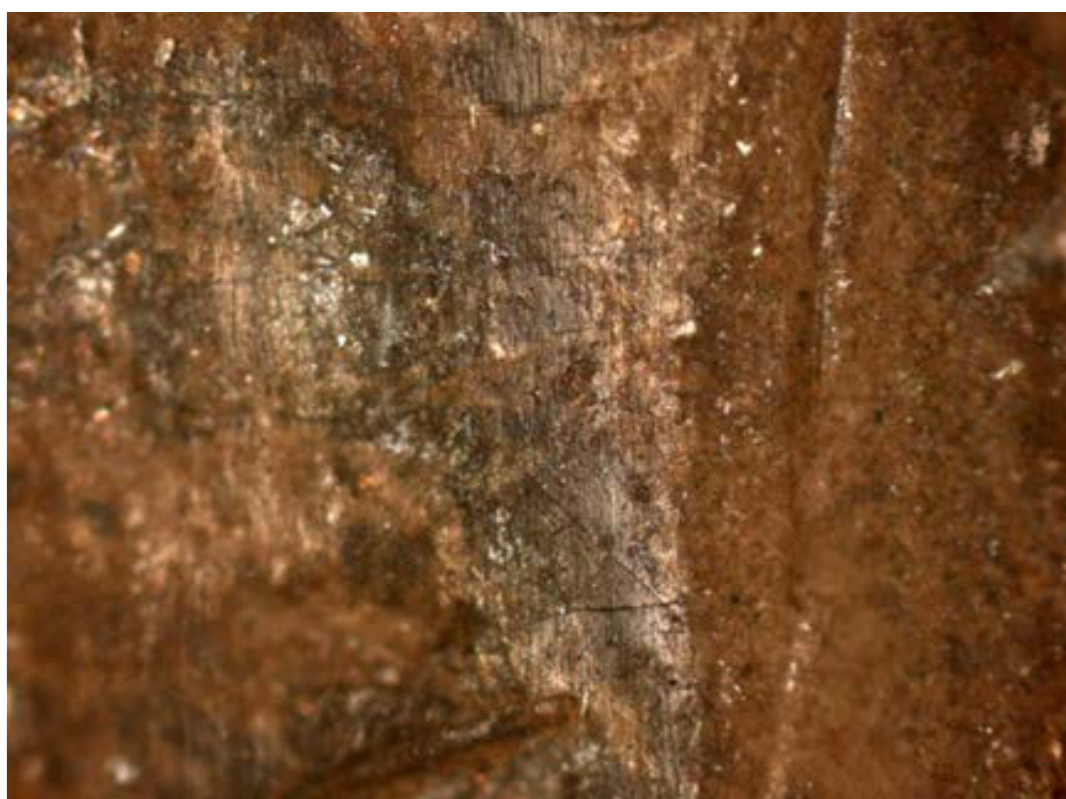
Figure 7. The use-wear traces (50x) in the groove left by straightening of the reed shafts. TGA talc replica. (Photo by S.N. Skochina.)